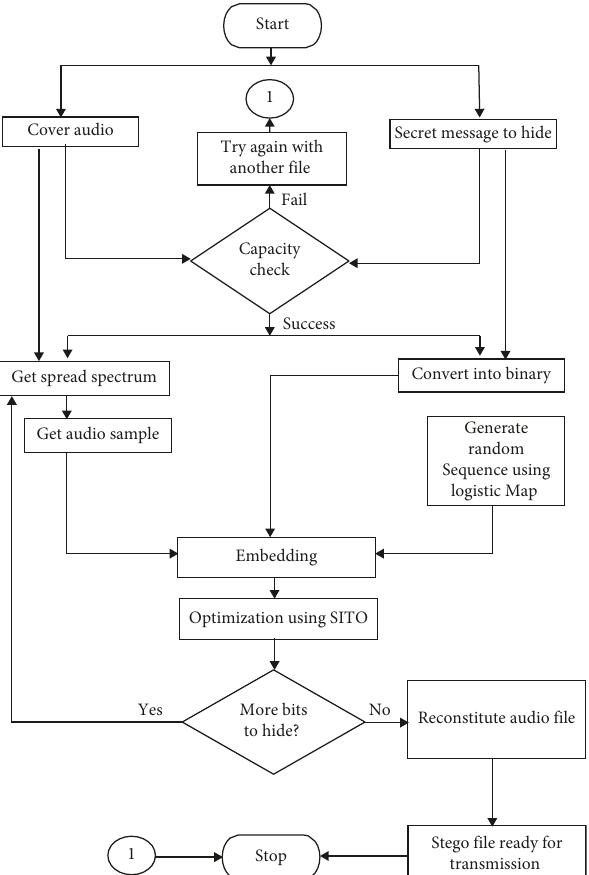
Figure 2: Flow chart of the proposed